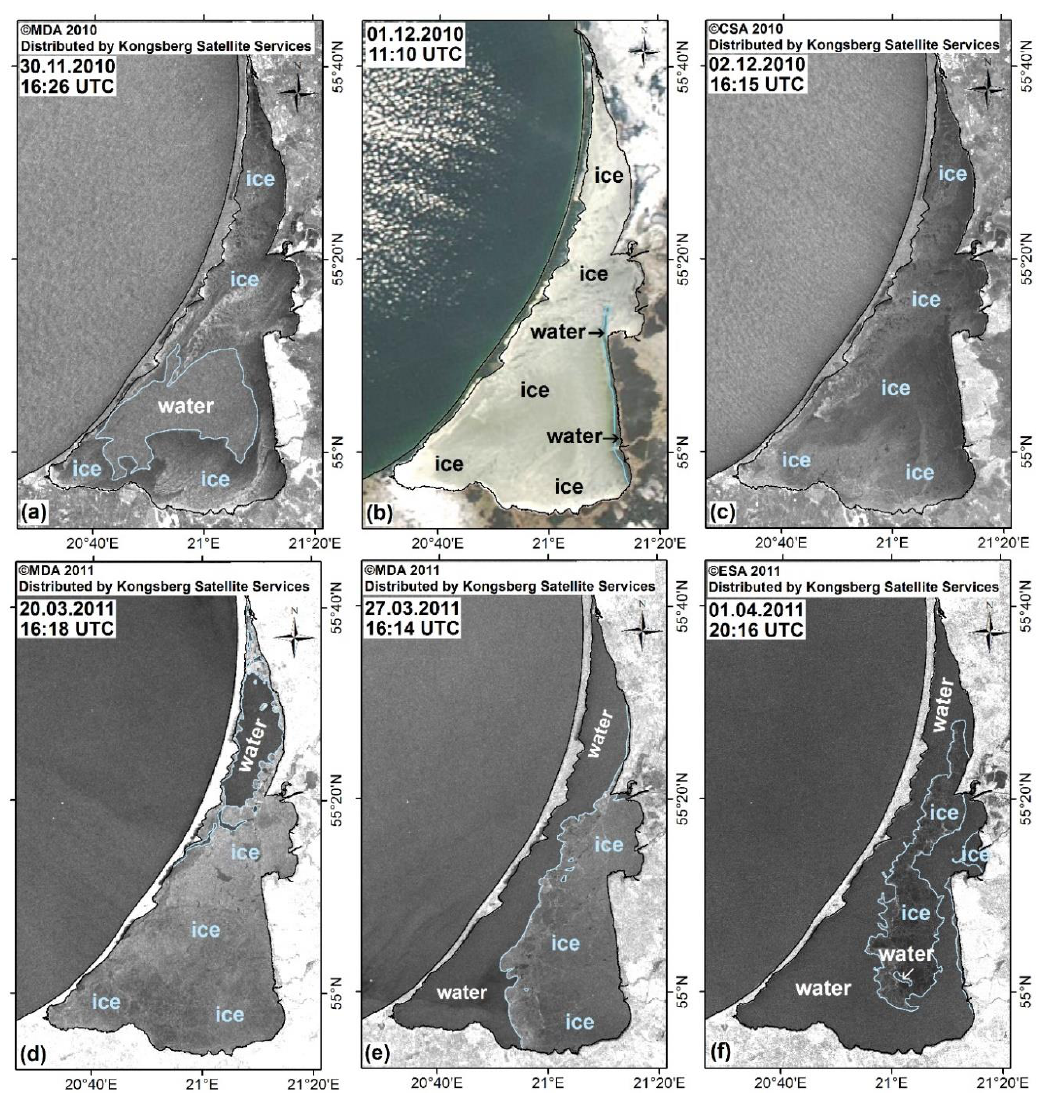
Figure 6. Ice formation and decay in the Curonian Lagoon during winter 2010–2011 as observed in: ( a ) RADARSAT-2 image of 30 November 2010 (16:26 UTC); ( b ) MODIS Aqua image of 1 December 2010; ( c ) RADARSAT-1 image of 2 December 2010 (16:15 UTC); ( d ) RADARSAT-2 image of 20 March 2011 (16:18 UTC); ( e ) RADARSAT-2 image of 27 March 2011 (16:14 UTC); ( f ) Envisat ASAR image of 1 April 2011 (20:16 UTC). Light blue contours mark the boundaries between the open water and the ice-covered regions.